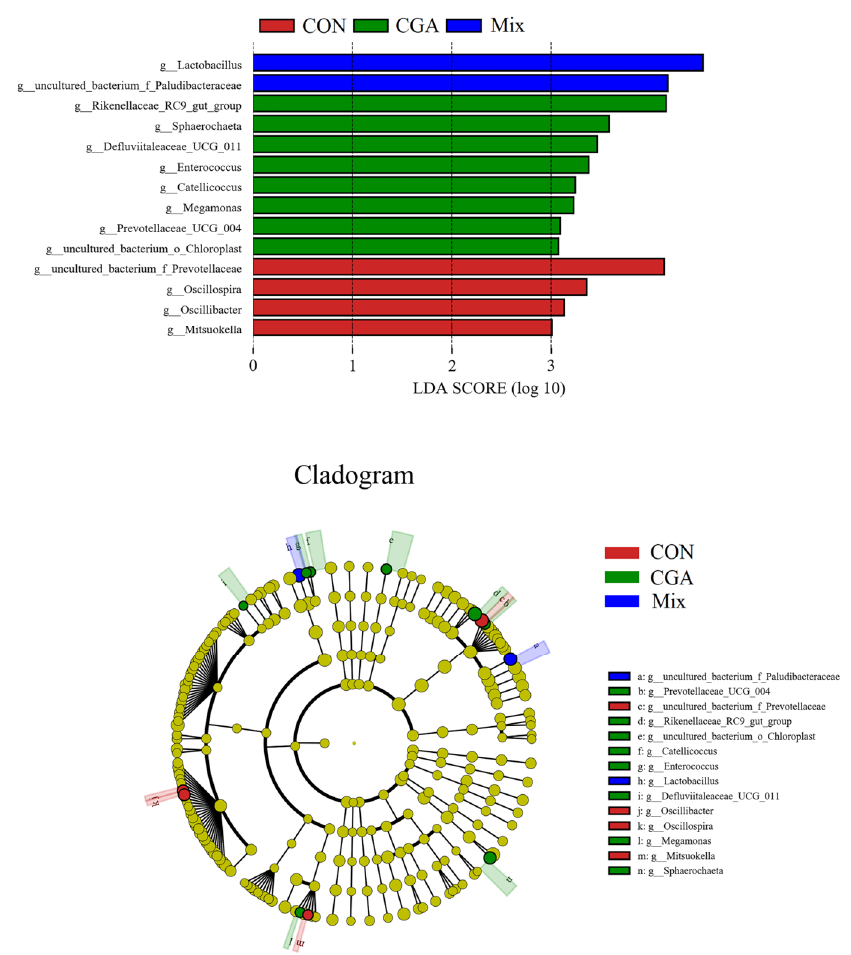
Figure 8. LDA distribution histogram and LEfSe cladogram. The radial circles of the cladogram represent the taxonomic levels from phylum to species. Each small circle at a different taxonomic level represents a taxon at that level, and the diameter of the small circles is proportional to the relative abundance. The coloring principle is to color the species with no significant difference in yellow, whereas the other species with differences are colored according to the group with the highest abundance. Different colors indicate different groups, and nodes with different colors indicate microbiotas that play an important role in the group represented by that